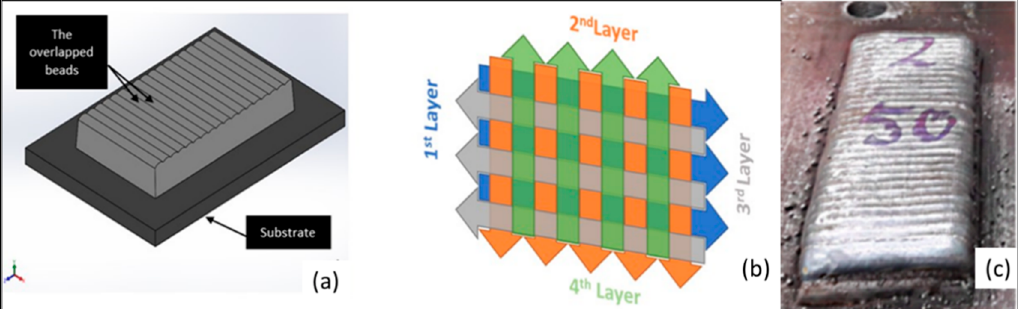
Figure 1. A picture for the additive/subtractive robotic-controlled manufacturing system, AMCL, the American University in Cairo.